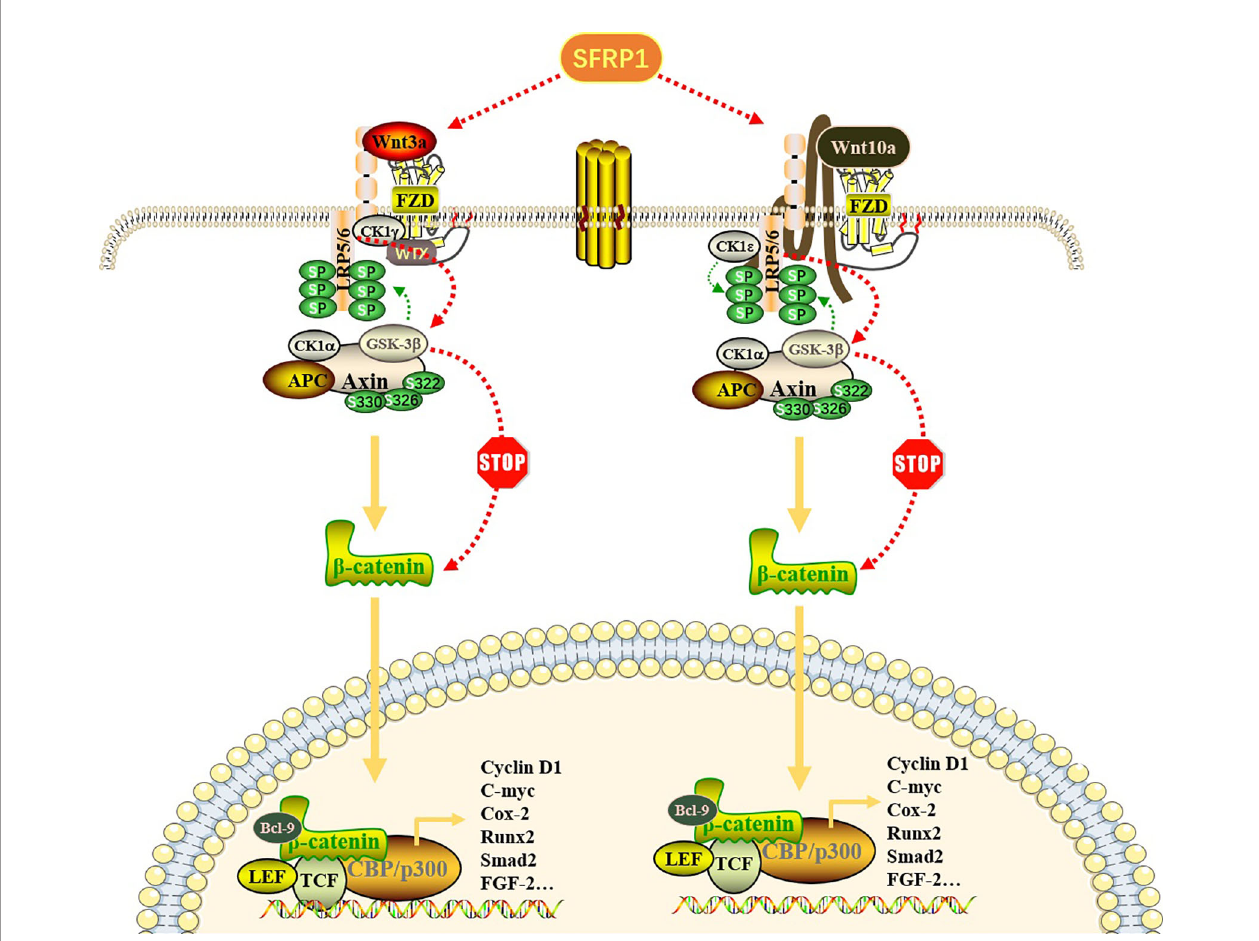
FIGURE 1 | Effect of SFRP1 on Wnt/ b -catenin signaling pathway. Wnt proteins (Wnt3a and Wnt10a) bind to FZD proteins located on the cell membrane to form a Wnt-FZD complex, which further binds to low-density lipoprotein receptor-related protein (LRP) 5/6 co-receptors, resulting in its cytoplasmic tail phosphorylation. When the pathway is not activated, b -catenin binds to the “ destruction complex ” composed of APC, GSK-3 b , CK1 a and Axin to promote its ubiquitin degradation. Once this pathway is activated, Axin dissociates from the destruction complex and binds to the phosphorylation site in the cytoplasmic tail of LRP. With the repositioning of Axin on LRP, the b -catenin released by the destruction complex is transported to the nucleus in the form of phosphorylation and binds to transcription factors, especially TCF and LEF, thereby regulating gene transcription and expression of related target genes. SFRP1 binds Wnt ligands through its CRD, thus preventing it from binding to FZD receptors, eliminating the accumulation of b -catenin and blocking the expression of downstream